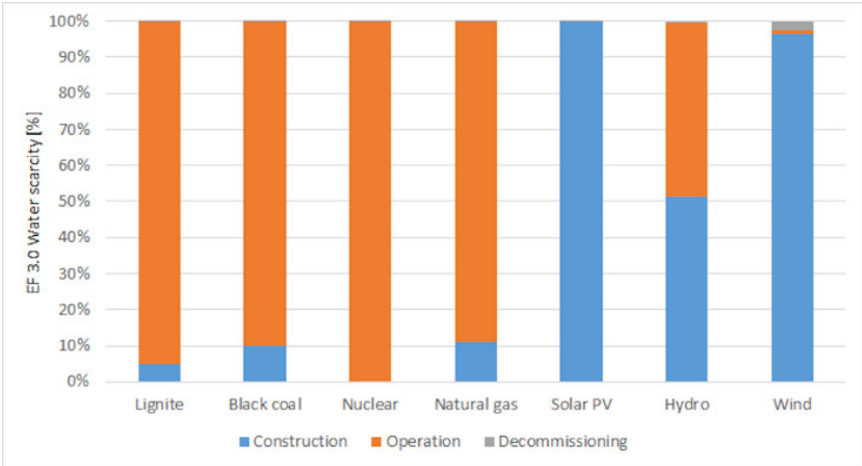
Figure 11. Contributions of the various life cycle phases (construction, operation and decommissioning) of electricity sources to respiratory inorganics. Environmental benefits excluded.